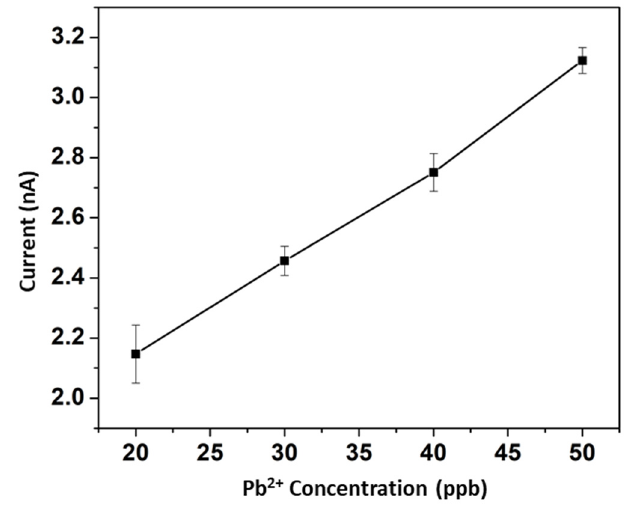
Figure 6. Sensing capability of CNTs bonded to metal surfaces for Pb 2+ detection. The peak current response from the SWASV analysis was extracted to construct a calibration curve using CNTs bonded to Cu as the working electrode.